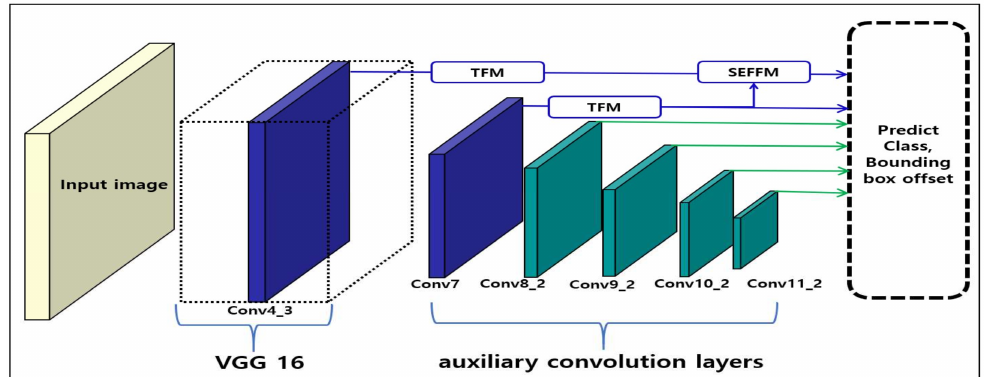
Figure 2. Overall structure of the single shot multi-box detector using trident feature and squeeze and extraction feature fusion (SSD-TSEFFM)—Conv4_3 and Conv7 feature maps pass through the trident feature module (TFM) and the squeeze and excitation block feature fusion module (SEFFM) to form new feature maps.